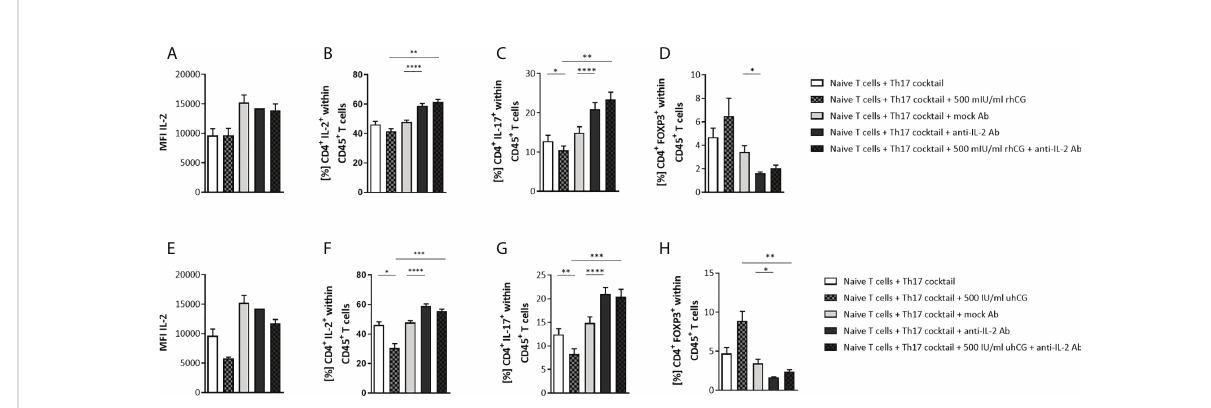
FIGURE 4 IL-2 blockage prevented the inhibition of Th17 differentiation by hCG in vitro. Naïve CD4 + T cells were isolated by magnetic-activated cell sorting (MACS) and polarized into Th17 cells under Th17-differentiating conditions for 3 days in vitro , in the presence or absence of 500 IU/ml uhCG or 500 mIU/ml rhCG, and anti-mouse IL-2 mAb or IgG2a isotype control mAb (mock Ab), respectively. Percentages of different T cell subsets as well as intracellular cytokine production were determined by fl ow cytometry. (A, E) Graphs showing intracellular IL-2 production in CD4 + T cells expressed as the mean MFI. (B – D, F – H) Graphs showing percentages of CD4 + IL-2 + , CD4 + IL-17 + and CD4 + FOXP3 + cells within CD45 + cells. Naïve T cells from WT ( n = 6) female mice were included in the assays. All assays were run in duplicate. Data are presented as the mean plus standard error of the mean (S.E.M.). Statistical analysis among groups was performed using repeated measures one-way ANOVA followed by Sidak ’ s multiple-comparison test. Following, means plus S.E.M. are provided for signi fi cant differences between groups for CD4 + IL- 2 + : 41.44 ± 1.921 vs 61.44 ± 1.799 (500mIU rhCG vs 500mIU rhCG plus anti-IL-2), 47.87 ± 1.251 vs 58.94 ± 1.567 (mock Ab vs anti-IL-2); 46.13 ± 2.104 vs 30.42 ± 3.153 (w/o hCG vs 500IU uhCG), 30.42 ± 3.153 vs 55.58 ± 1.246 (500IU uhCG vs 500IU uhCG plus anti-IL-2), 47.87 ± 1.251 vs 58.91 ± 1.567 (mock Ab vs anti-IL-2); for CD4 + IL-17 + : 12.81 ± 1.461 vs 10.46 ± 1.085 (w/o hCG vs 500mIU rhCG), 10.46 ± 1.085 vs 23.34 ± 1.892 (500mIU rhCG vs 500mIU rhCG plus anti-IL-2), 14.87 ± 1.574 vs 20.90 ± 1.706 (mock Ab vs anti-IL-2), 12.41 ± 1.257 vs 8.271 ± 1.101 (w/o hCG vs 500IU uhCG), 8.271 ± 1.101 vs 20.38 ± 1.609 (500IU uhCG vs 500IU uhCG plus anti-IL-2), 14.87 ± 1.285 vs 21.00 ± 1.396 (mock Ab vs anti-IL-2); for CD4 + FOXP3 + : 3.434 ± 0.5329 vs 1.628 ± 0.09477 (mock Ab vs anti-IL-2), 8.879 ± 1.225 vs 2.403 ± 0.2150 (500IU uhCG vs 500IU uhCG plus anti-IL-2), 3.434 ± 0.5329 vs 1.628 ± 0.09477 (mock Ab vs anti-IL-2). * indicates p < 0.05; ** indicates p < 0.01; *** indicates p < 0.001; **** indicates p < 0.0001. rhCG, recombinant hCG; uhCG, urine-derived hCG.